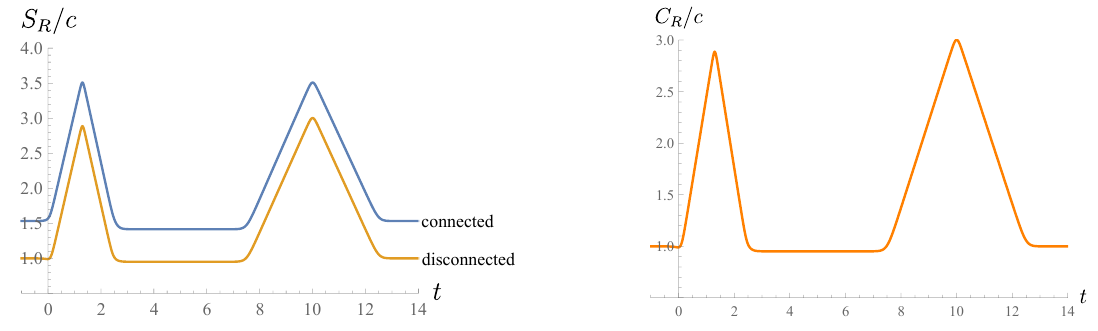
Figure 10 . The entropy [Left] and capacity [Right] in the moving mirror model whose trajectory mimics an evaporating black hole. We set the subsystem to be R = [ z ( t )+0 . 1 , z ( t )+10] with β = 0 . 1 , (cid:15) = 0 . 1 and S bdy /c = 0 . 1 . In this model, there is no phase transition between the connected and disconnected channels, hence the capacity does not have any